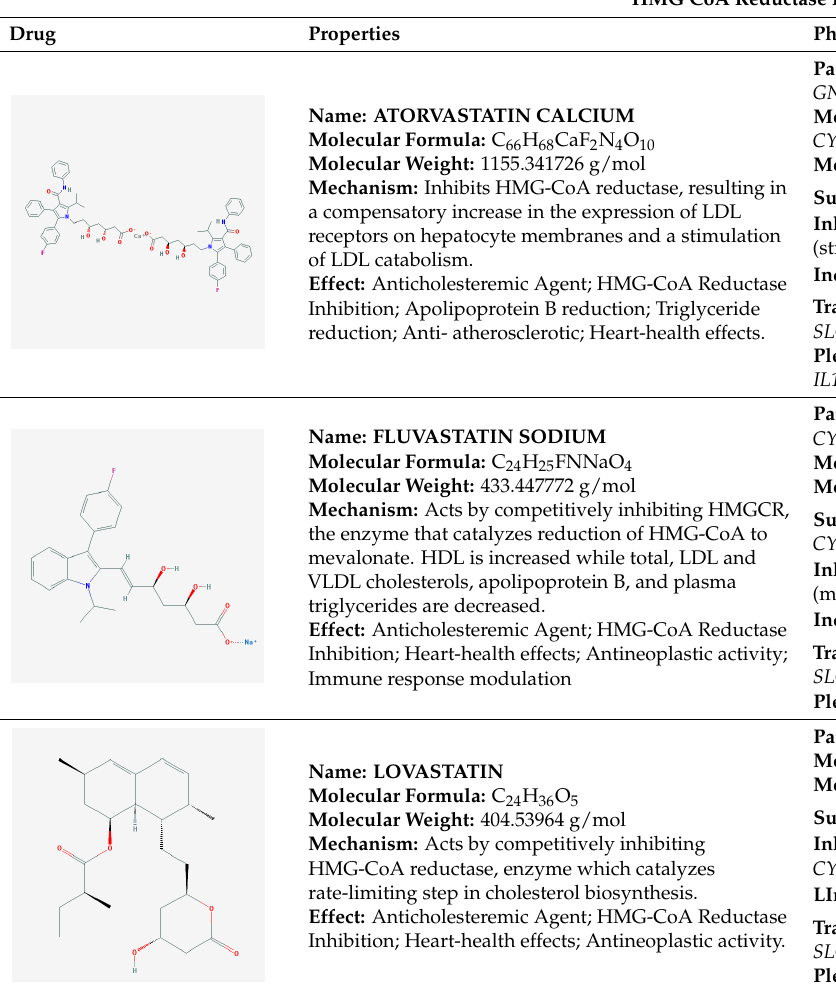
Table 1. Pharmacological properties and pharmacogenetics of statins. Table 1 Pharmacological properties and pharmacogenetics of statins. Table 1 Pharmacological properties and pharmacogenetics of statins. Table 1 Pharmacological properties and pharmacogenetics of